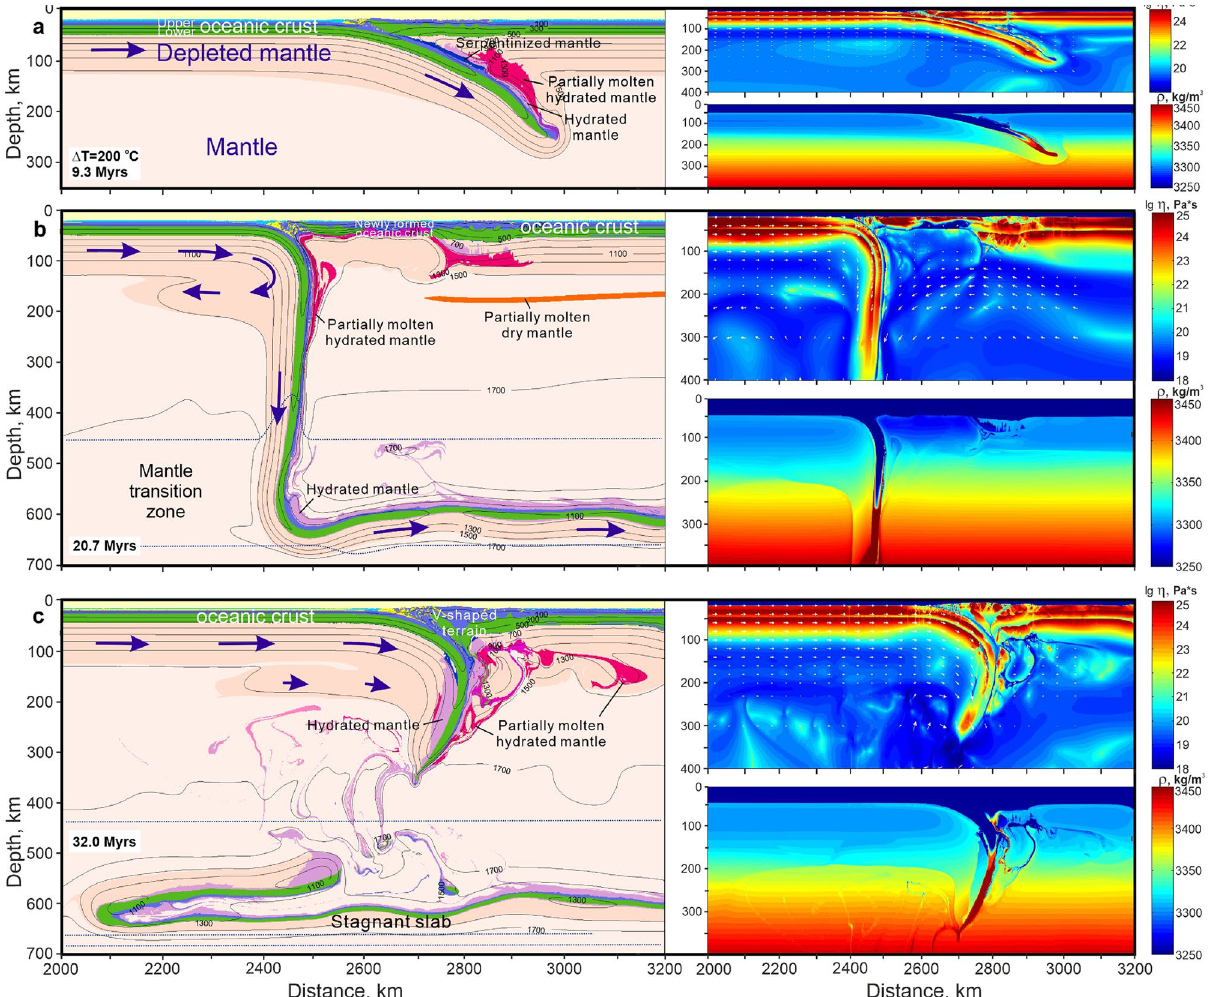
Figure 3. Development of viscous underplating during one-sided ocean–ocean subduction at constant convergence velocity of 5 cm/year and elevated mantle temperature ΔT = 200 °C (T p = 1,500 °C). ( a ) Flat ocean–ocean subduction with highly depleted mantle with low density (9.3 myrs from the beginning of the experiment). Eclogitization of the subducting oceanic crust (density ≥ 3450 kg/m 3 ) occurs at ~ 120 km depth. ( b ) Vertical subduction, development of the viscous underplate, slab retreat accompanied by back-arc spreading (20.7 myrs from the beginning of the experiment). Note the reverse viscous flow of the depleted mantle detached from the slab on the left-and formation of visous underplate. Eclogitization of the subducting oceanic crust (density ≥ 3450 kg/m 3 ) occurs at ~ 250 km depth. ( c ) Formation of the V-shaped terrain during closure of the back-arc basin after slab break-off. Note that the depleted mantle is over-thickened around the subduction zone (32 myrs from the beginning of the experiment). Density and effective viscosity fields with velocity vectors are shown for each stage as separate panels at the bottom right and at the top right, respectively. Dotted dark- blue lines in b and c left column indicate an actual upper and lower boundaries of the mantle transition zone. Arrows show direction of plate motion (not to scale) and viscous flow of the depleted mantle. The colour key is as in Fig. 2. Prescribed velocity of the left-hand plate is 5